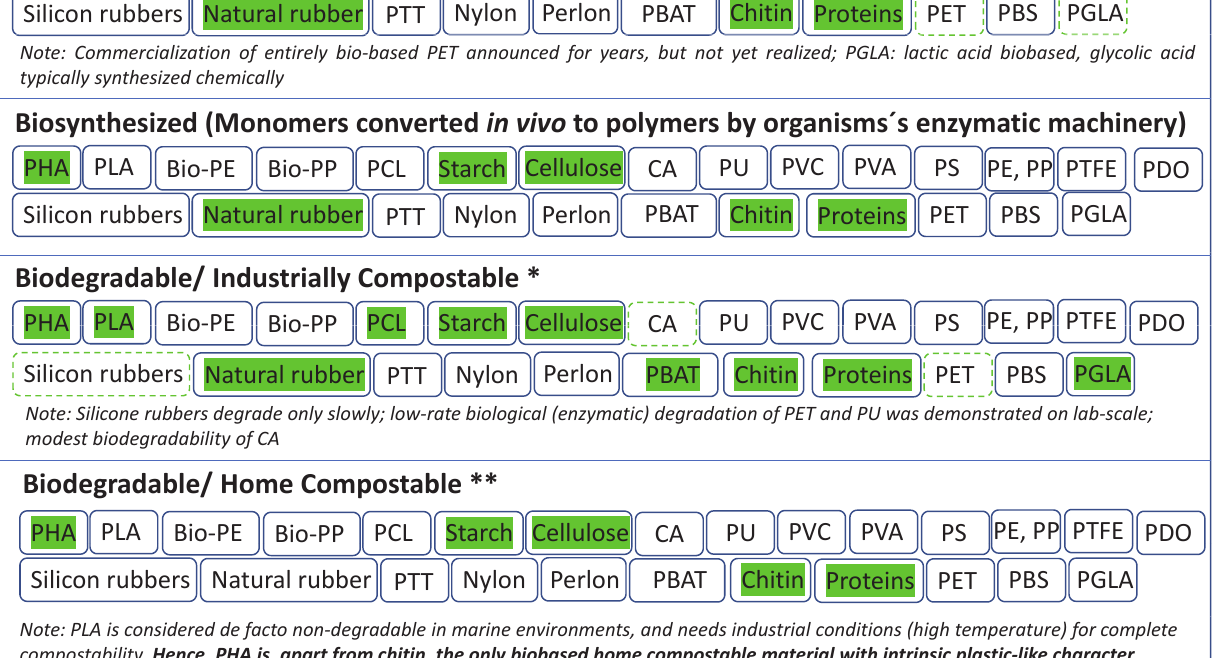
Fig. 1 – Classification of diverse polymers. Polymers marked in green meet the criteria “biobased”, “biosynthesized”, or “biode- gradable/compostable”. PHA: Polyhydroxyalkanoates; PLA: poly(lactic acid); Bio-PE: bio-based poly(ethylene); Bio-PP: bio-based poly(propylene); PCL: poly(ε-caprolactone); PU: poly(urethane); PVC: poly(vinyl chloride); PVA: poly(vinyl alcohol); PS: poly(sty - rene); CA: cellulose acetate; PTFE: poly(tetrafluoroethylene) (Teflon®); PDO: poly(dioxanone); PTT: poly(trimethylene